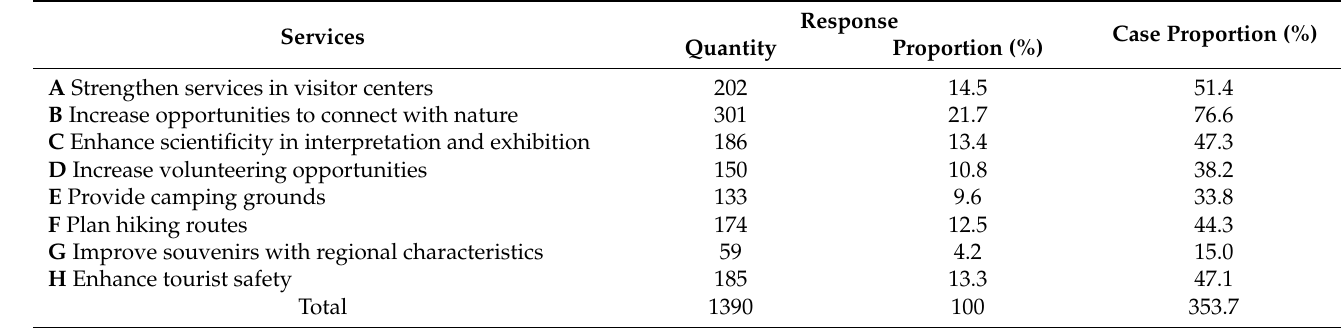
Table 4. The expectation of recreational services of Wuyishan National